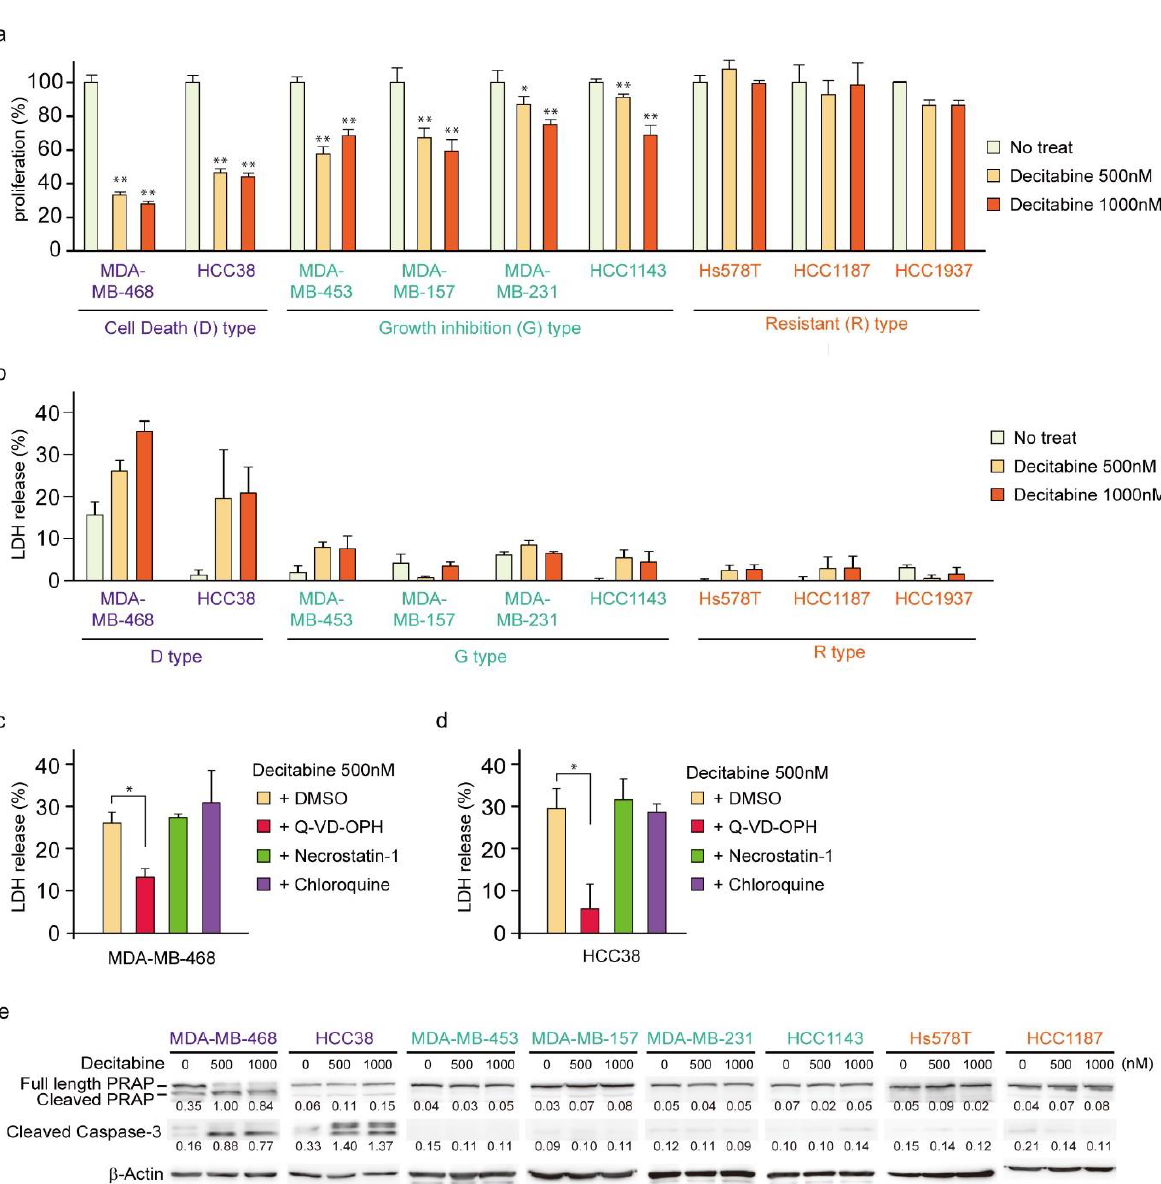
Figure 1. Effects of low-dose decitabine in nine TNBC cell lines. ( a , b ) Cells were exposed to the indicated amounts of decitabine (500 or 1000 nM). After treatment for 72 h, cell proliferation was measured by CCK-8 analysis ( a ) and cell death was measured by LDH release analysis ( b ). ( c , d ) MDA-MB-468 ( c ) and HCC38 ( d ) cells were treated with the indicated agents. After treatment for 72 h, cell death was determined using LDH release analysis. Error bars indicate SD ( n = 3). The data are expressed as the mean ± SD of triplicate experiments. *, p < 0.05; **, p < 0.01. ( e ) Cells were exposed to the indicated amounts of decitabine (500 or 1000 nM). After treatment for 72 h, equal amounts of total cell lysate were subjected to immunoblot analysis with the indicated antibodies. Numbers below blots represent the relative band intensity of each protein normalized to the signal intensity of β -actin. The uncropped immunoblot images can be found in Figure